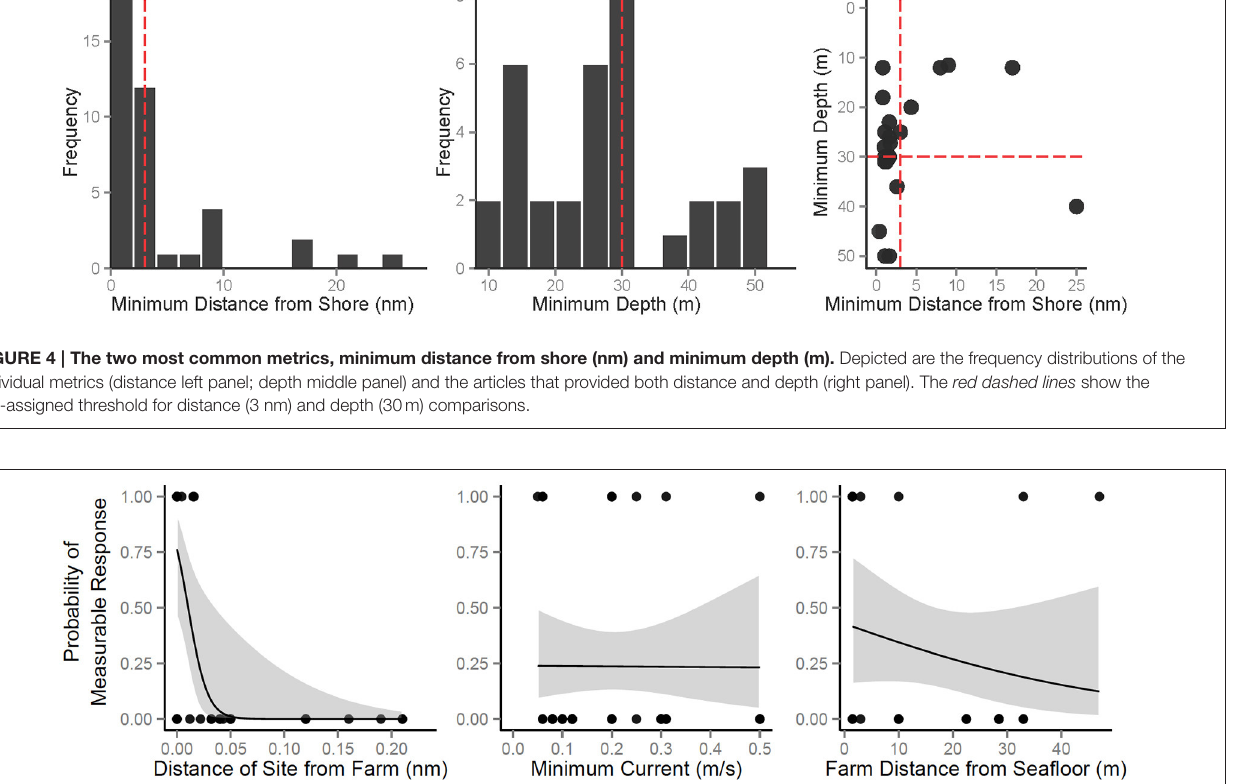
FIGURE 5 | Probability of measurable response given sampling distance from the farm (left panel), minimum current (middle panel), or distance of the cage(s) from the seafloor (right panel). Response data points are depicted as black dots (response = 1; no response = 0). For better visualization, a truncated view of the sample distance from farm probability distribution is depicted, but all data points were used in the GLM analyses [max sample distance (no response) = 1.51 nm].